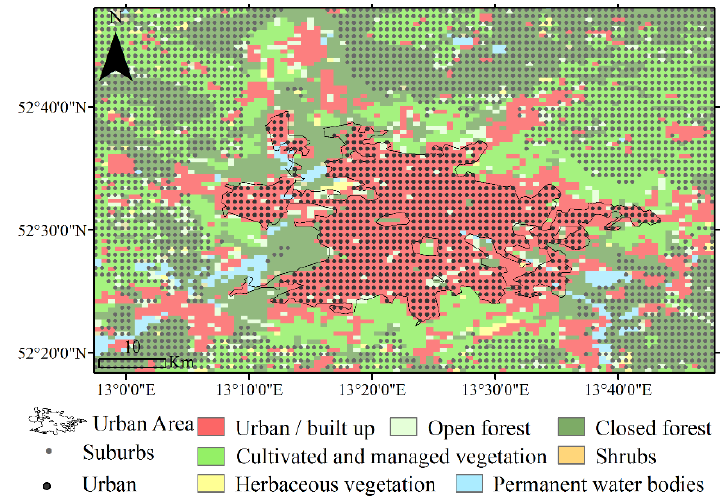
Figure 3. A sample land cover image to separate the city of Berlin from its surroundings (similar images were used for the other cities under study).